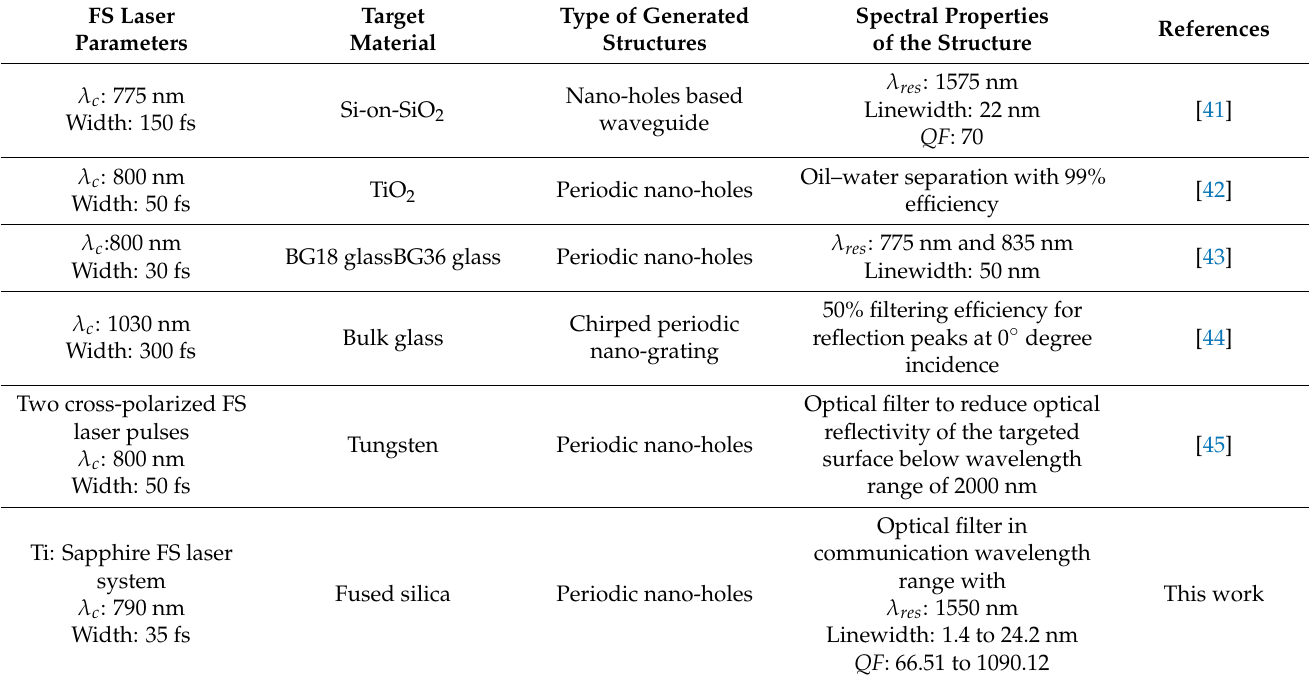
Table 2. Comparative analysis of the presented work with the literature for optical filtering properties. Spectral Properties Structures of the